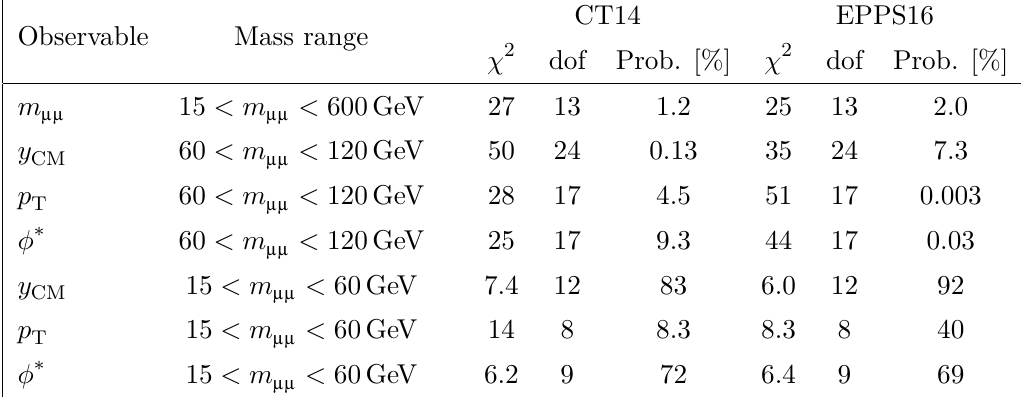
Table 3 . χ 2 values between the data and the powheg predictions and associated probability, from the full phase space cross sections, when experimental and theoretical bin-to-bin correlations are taken into account. The integrated luminosity uncertainty is included in the experimental